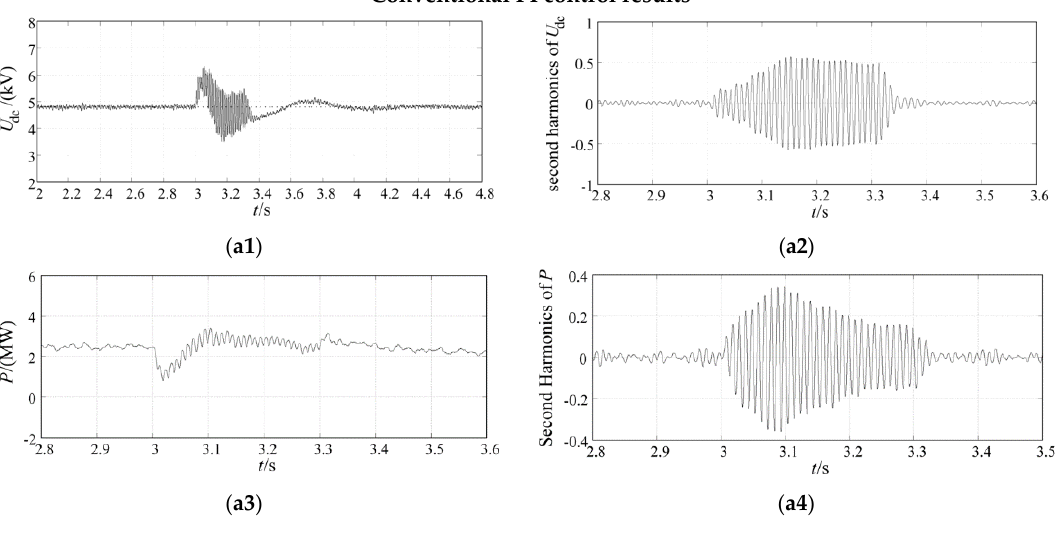
Figure 10. Cont. Figure 10.